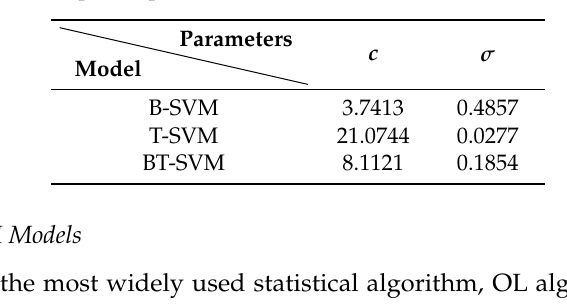
Figure 6. Parameter optimization of three SVM models with different kernel functions.